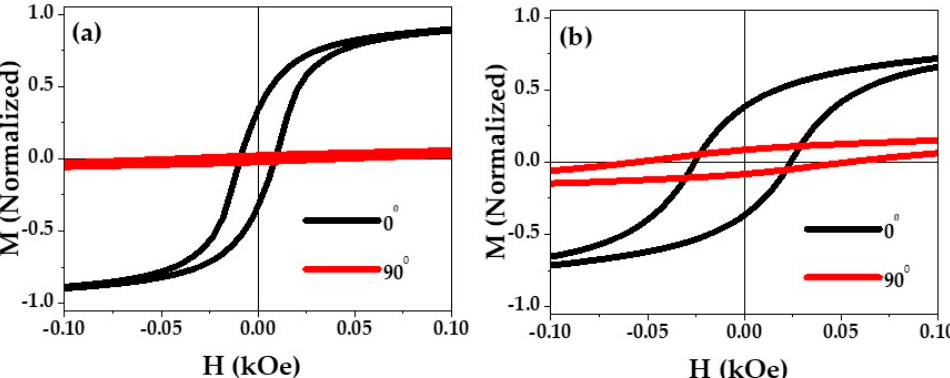
Figure 1. Co 2 MnSi glass-coated microwires, both as-prepared samples ( a ) and samples annealed at 1023 K for (2 h) ( b ); in-plane (parallel to the wire axis, black loop) and out-of-plane (perpendicular to the wire axis, red loop) hysteresis loops were measured at room temperature. Table 2. The magnetic parameters of Co 2 MnSi glass-coated microwires of as-prepared and annealed samples in IP and OOP directions.